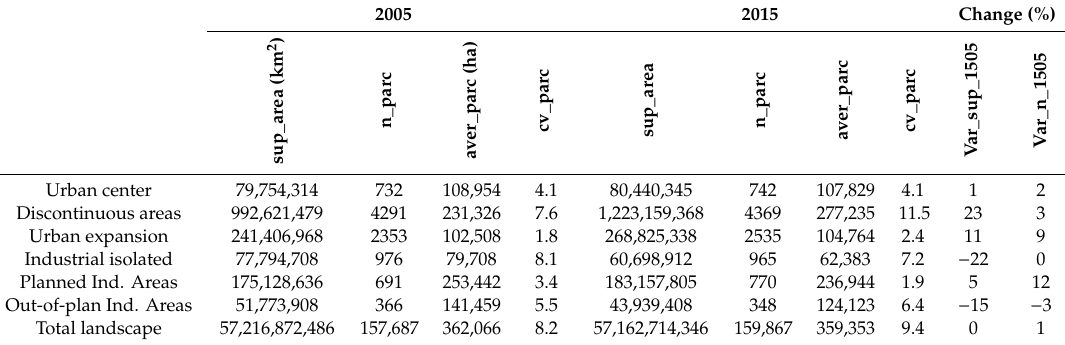
Table 2. Indicators and descriptive